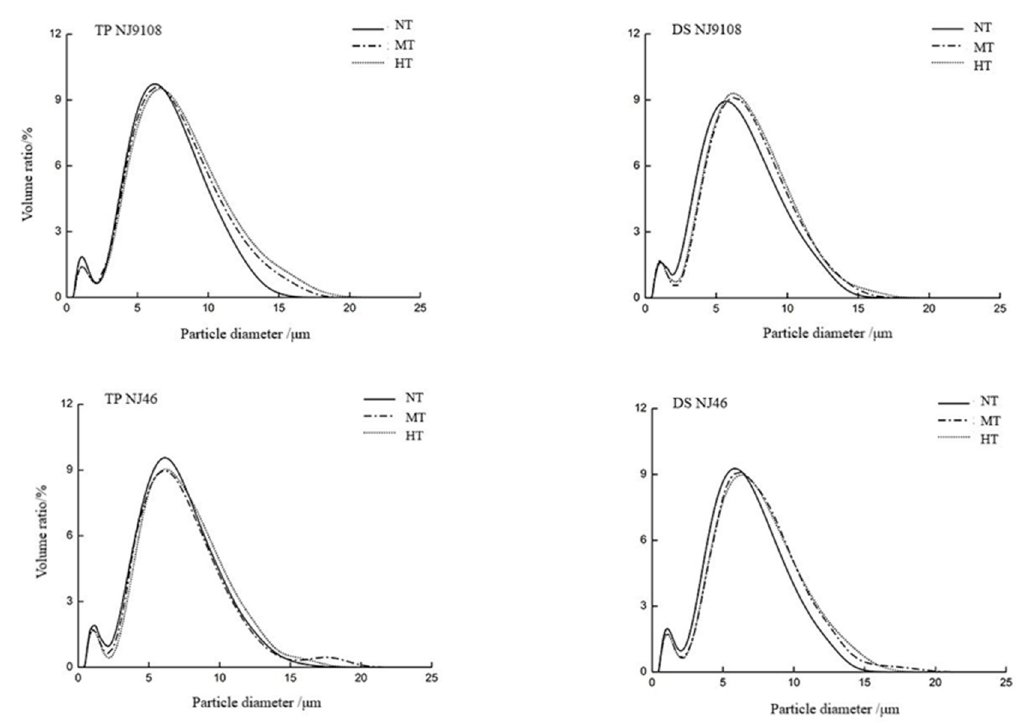
Figure 3. Effects of high temperature on starch particle size distribution of japonica rice in early heading stage under transplanting and direct seeding.